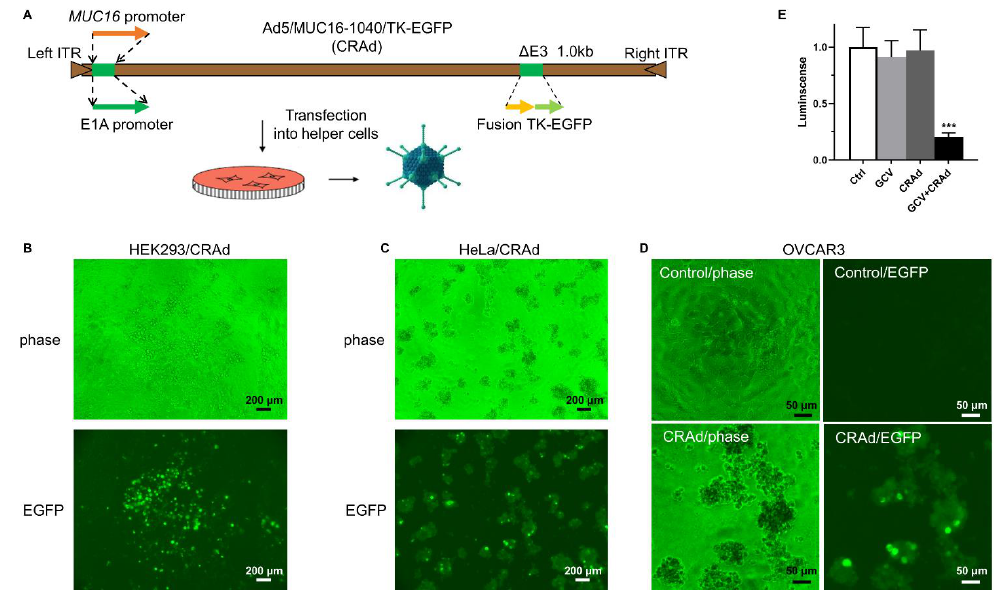
Figure 2. Generation of recombinant CRAd with MUC16 1040 bp upstream fragment to control E1A expression. ( A ). Illus- tration of CRAd genome recombination. E1A promoter of Ad5 was replaced by the MUC16 1040 fragment. HSV-TK was inserted in the E3 region. ( B ). Ad5/MUC16-1040/TK-EGFP was packaged using HEK293 cells and assessed for viral plague formation and EGFP expression, scale bar: 200 μ m, magnification: 40 × . ( C ). Oncolysis (CPE) of HeLa cells, scale bar: 200 μ m, magnification: 40 × . ( D ). Oncolysis (CPE) of OVCAR3 cells, scale bar: 50 μ m, magnification: 200 × . ( E ). GCV-induced cell death in the virus-infected mouse ovarian cancer line ID8 cells, *** p = 0.0007 vs. Ctrl, n = 3.